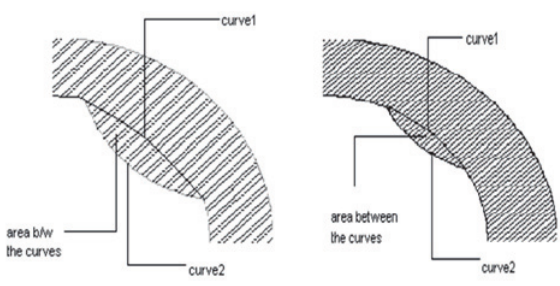
Fig. 5. Area between the curves in star and rose petal grain configuration (in first